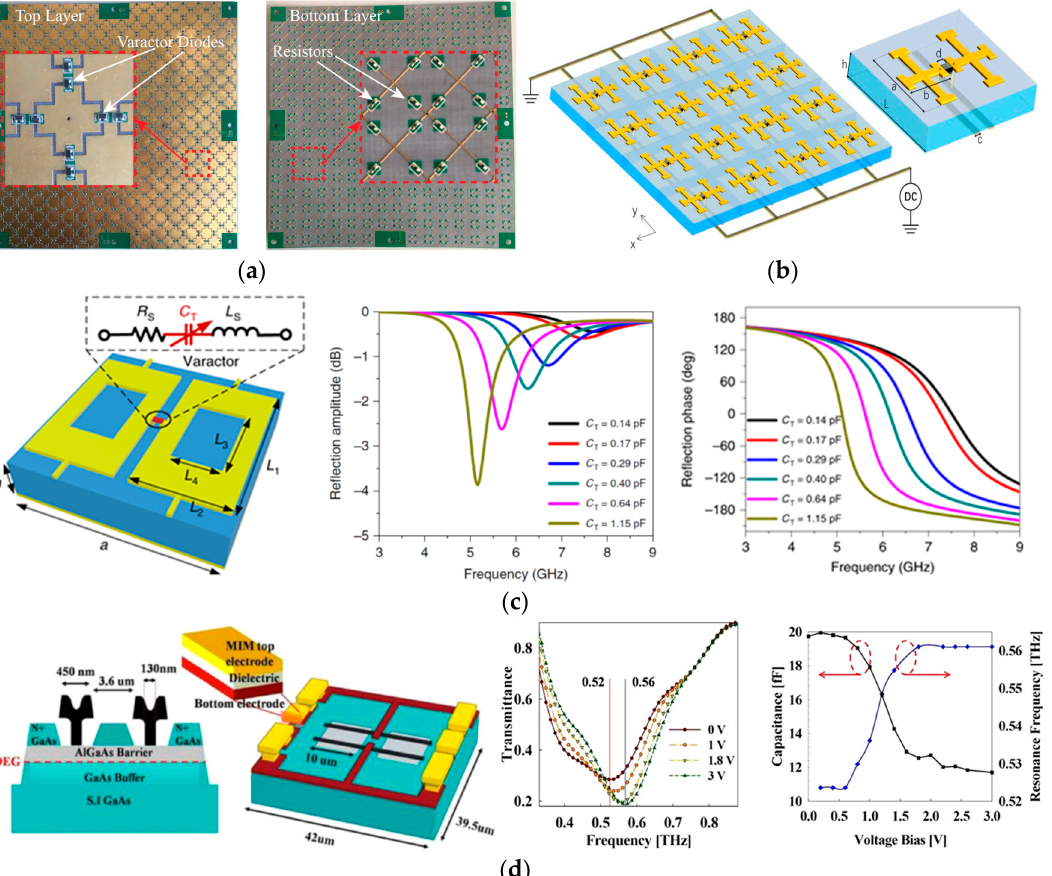
Figure 2. Active and programmable metasurfaces with varactor diodes. Frequency modulation of ( a ) FSS [28] and ( b ) EIT structures [29]. The varactor diodes change the coupling capacitance of the metasurfaces. ( c ) Hollow patch RIS with varactor diodes [11]. The diode actively modulates the reflection phase by sweeping the resonant frequency, where the metasurface shows abrupt phase change. Copyright Nature, 2020. ( d ) Terahertz metasurface modulated with MSM varactors [37]. The high − frequency MSM structure is a combination of two Schottky capacitors on the top of AlGaAs/InGaAs/GaAs double heterostructure.